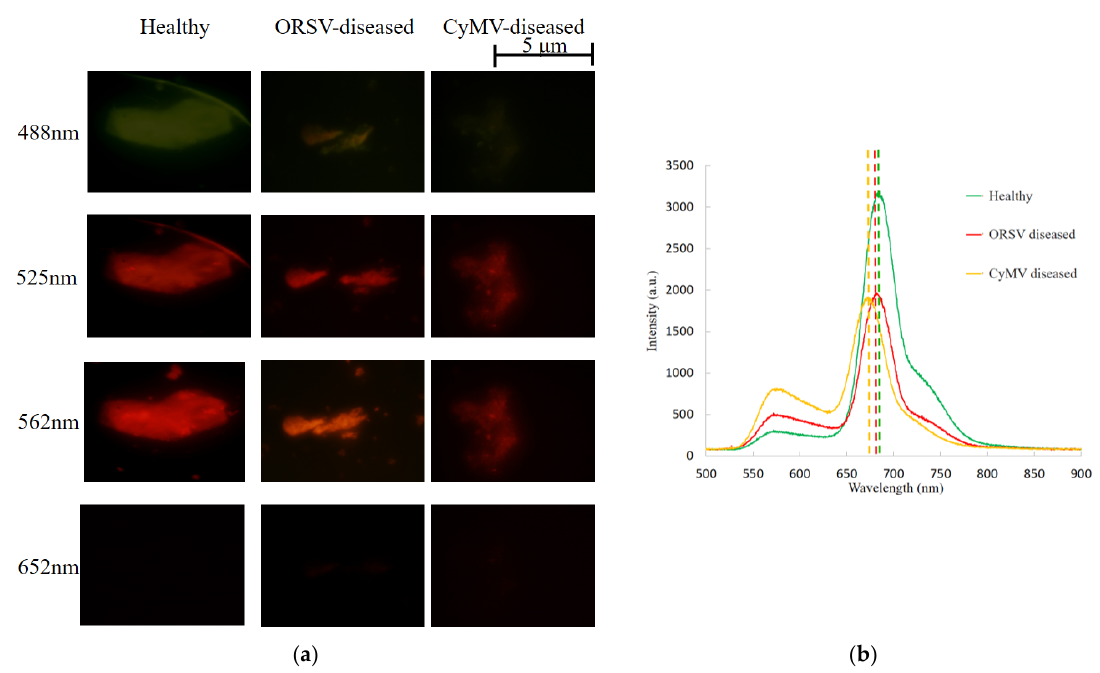
Figure 1. Optical fluorescence characterization of the extracted solutions of Odontoglossum ringspot virus (ORSV)- or Cymbidium mosaic virus (CyMV)-diseased, ORSV-diseased, and healthy plants. ( a ) Fluorescence microscopy images under 652, 562, 525, and 488 nm excitation light. ( b ) Fluorescence spectra under 532 nm green laser excitation as displayed by the optical spectrum analyzer (OSA).